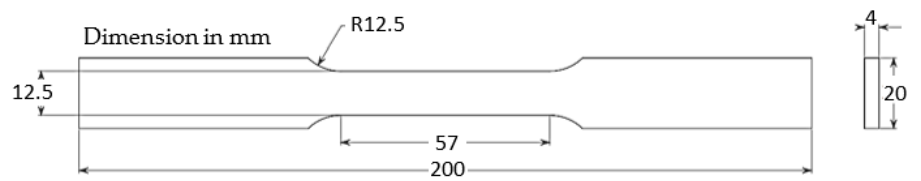
Figure 7. Geometry of samples for tensile test.